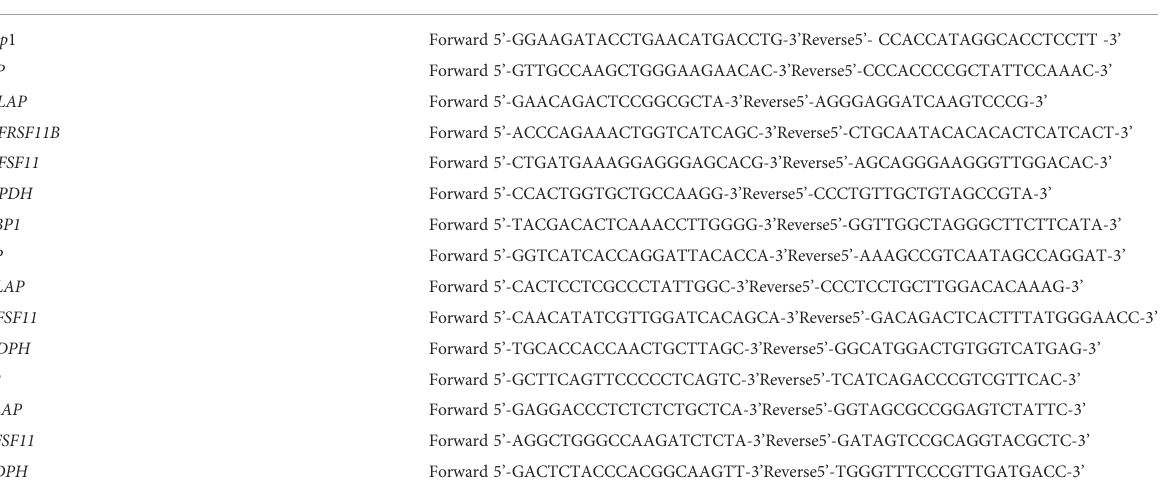
TABLE 2 The primers used for quantitative